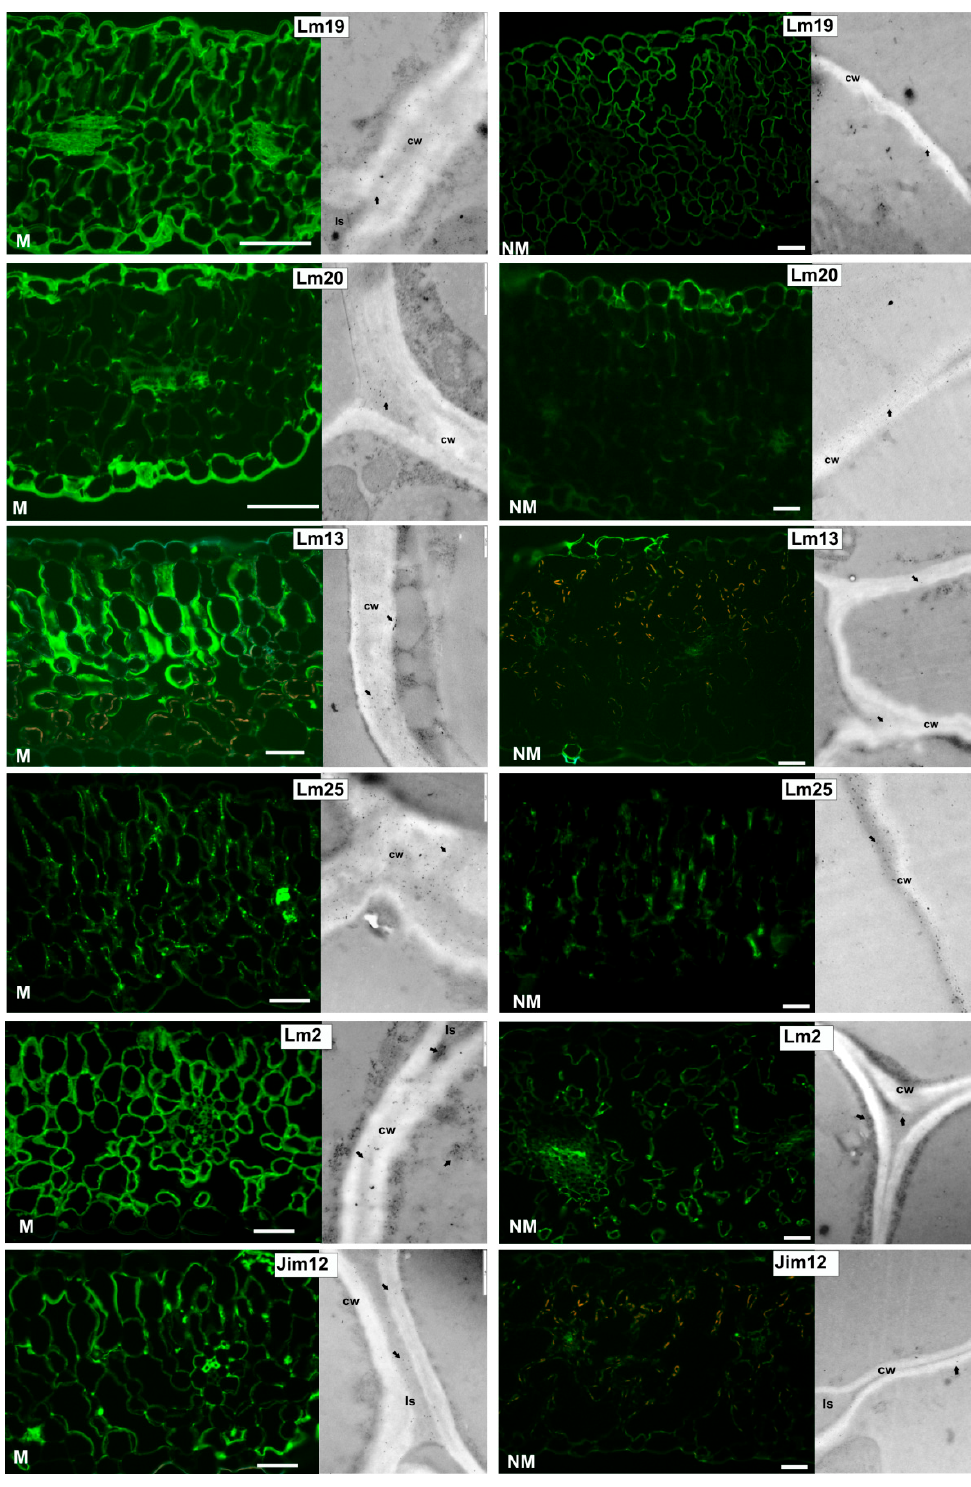
Figure 3. Localization of cell wall components in transversal sections of metallicolous (M) and non-metallicolous (NM) Anthyllis leaves using immunofluorescence and immunogold labelling. Note that the M leaves are strongly labelled with all antibodies. Arrows indicate colloidal gold deposits. cw:cell wall; Is:intercellular space. Bars = 50 µm.